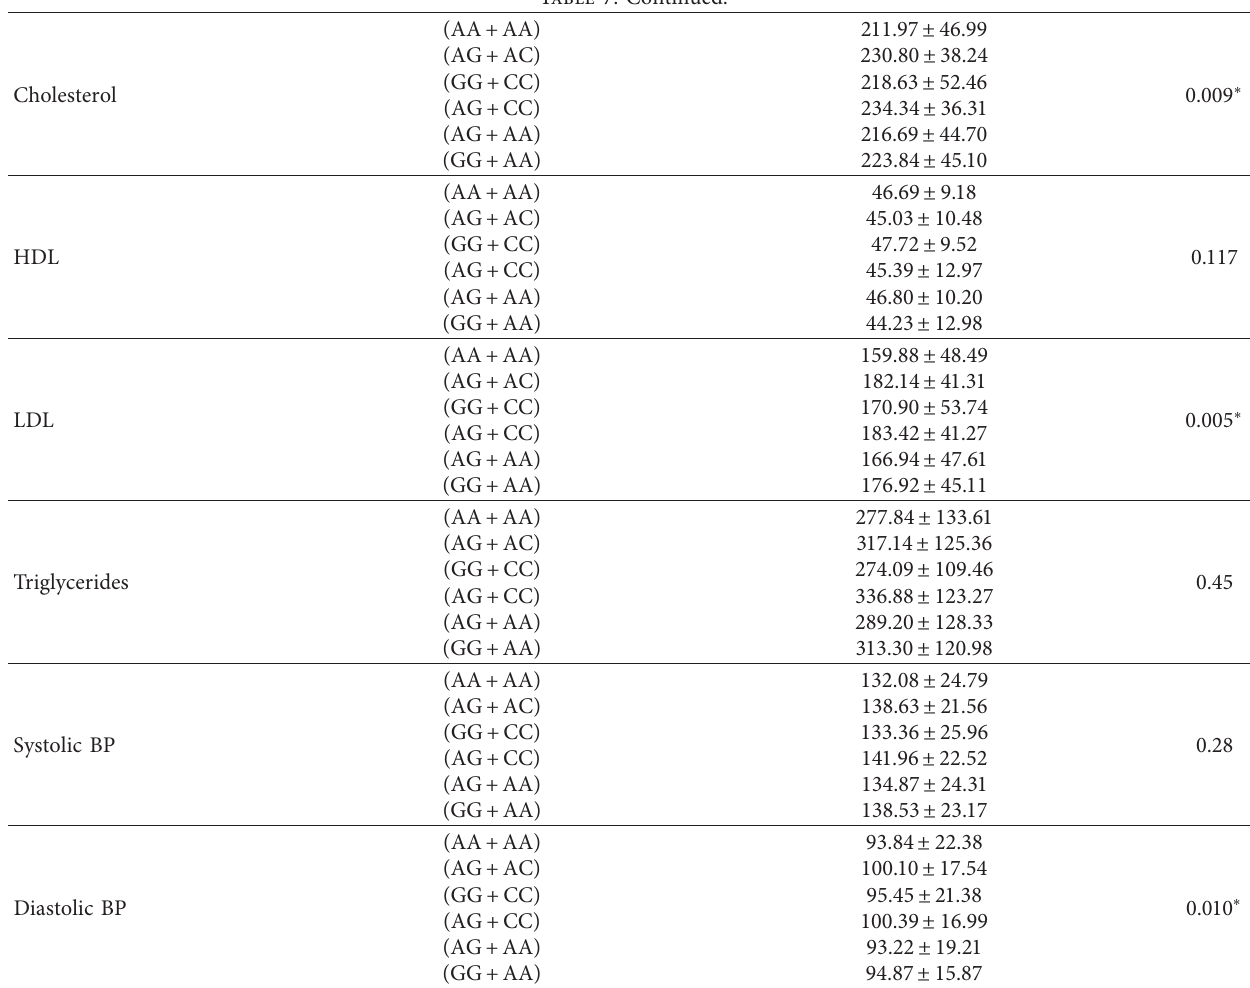
Table 8: Regression analysis: dependent variable cases and control. Variables